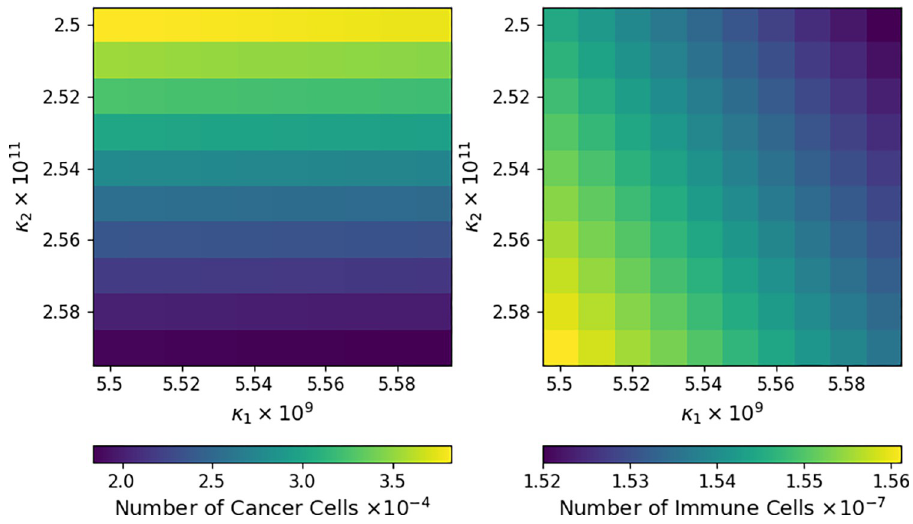
Fig 1. Sensitivity of Cancer and Immune Cells in the CARRGO Model. A heatmap representing the number of cancer cells, or x ( t ) (left) and the number of immune cells, or y ( t ) (right) as the parameters κ 1 (horizontal axis) and κ 2 (vertical axis) are varied. Results displayed summarize simulations of the CARRGO model with parameter values and initial conditions indicated in this section at time t = 1000 days.